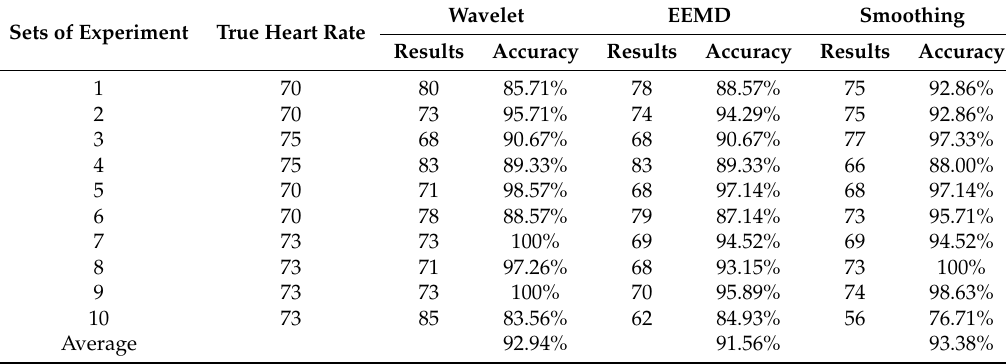
Table 6. The results of the heart-rate test with the time period of 10